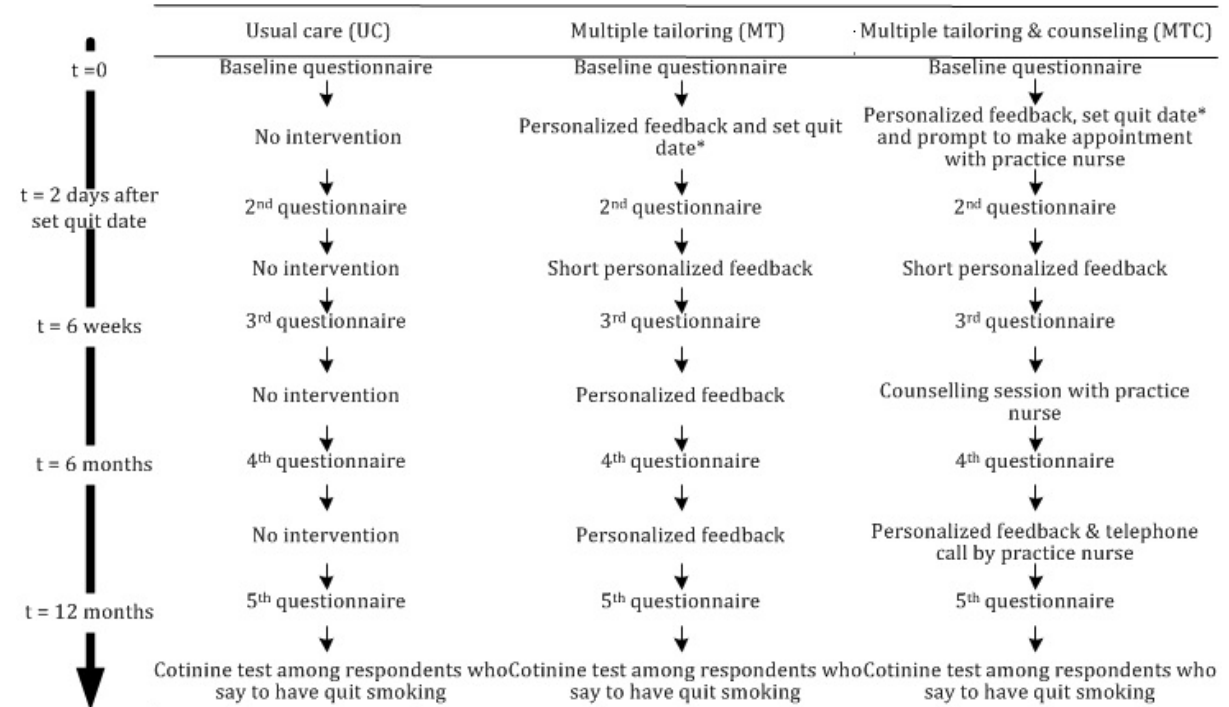
Figure 1. Overview of the intervention elements received by the 3